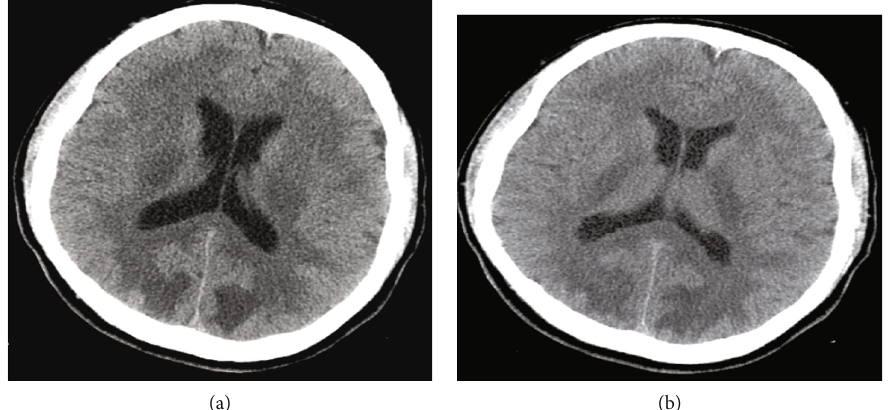
Figure 1: (a, b) Computed tomography scan of the brain without contrast, showing white matter disease in both cerebral hemispheres and cerebellum.